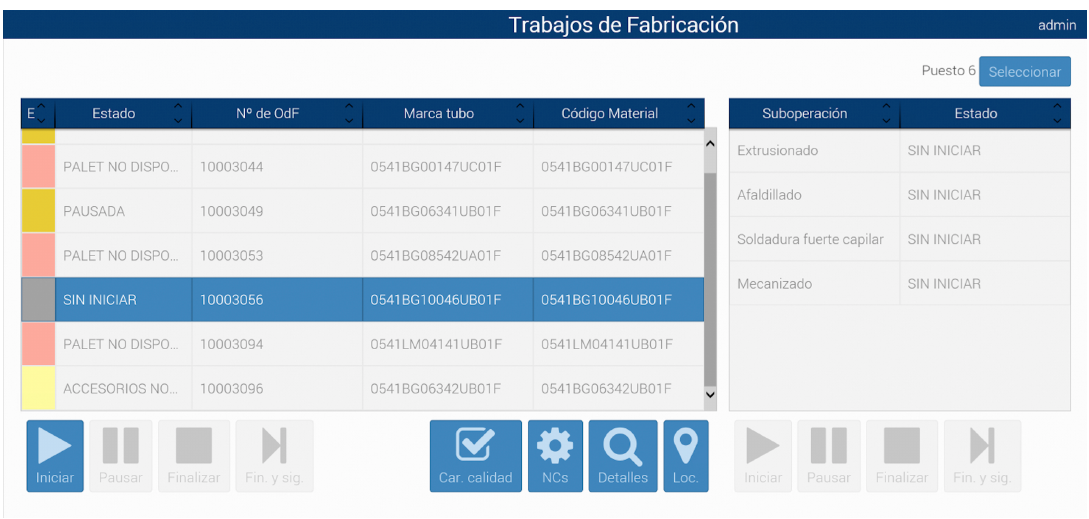
Figure 15. Screenshot of a manufacturing task pool of the